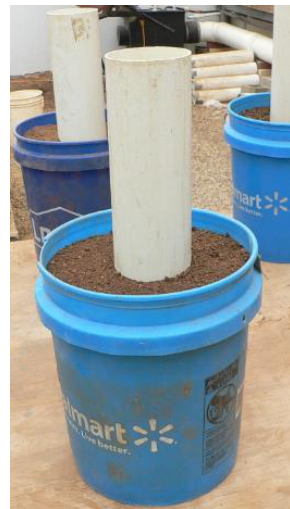
Figure 5. Setup for adding Verticillium dahliae inoculated soil to pots to measure impact on cotton photosynthesis rate, lint production, and fiber quality.